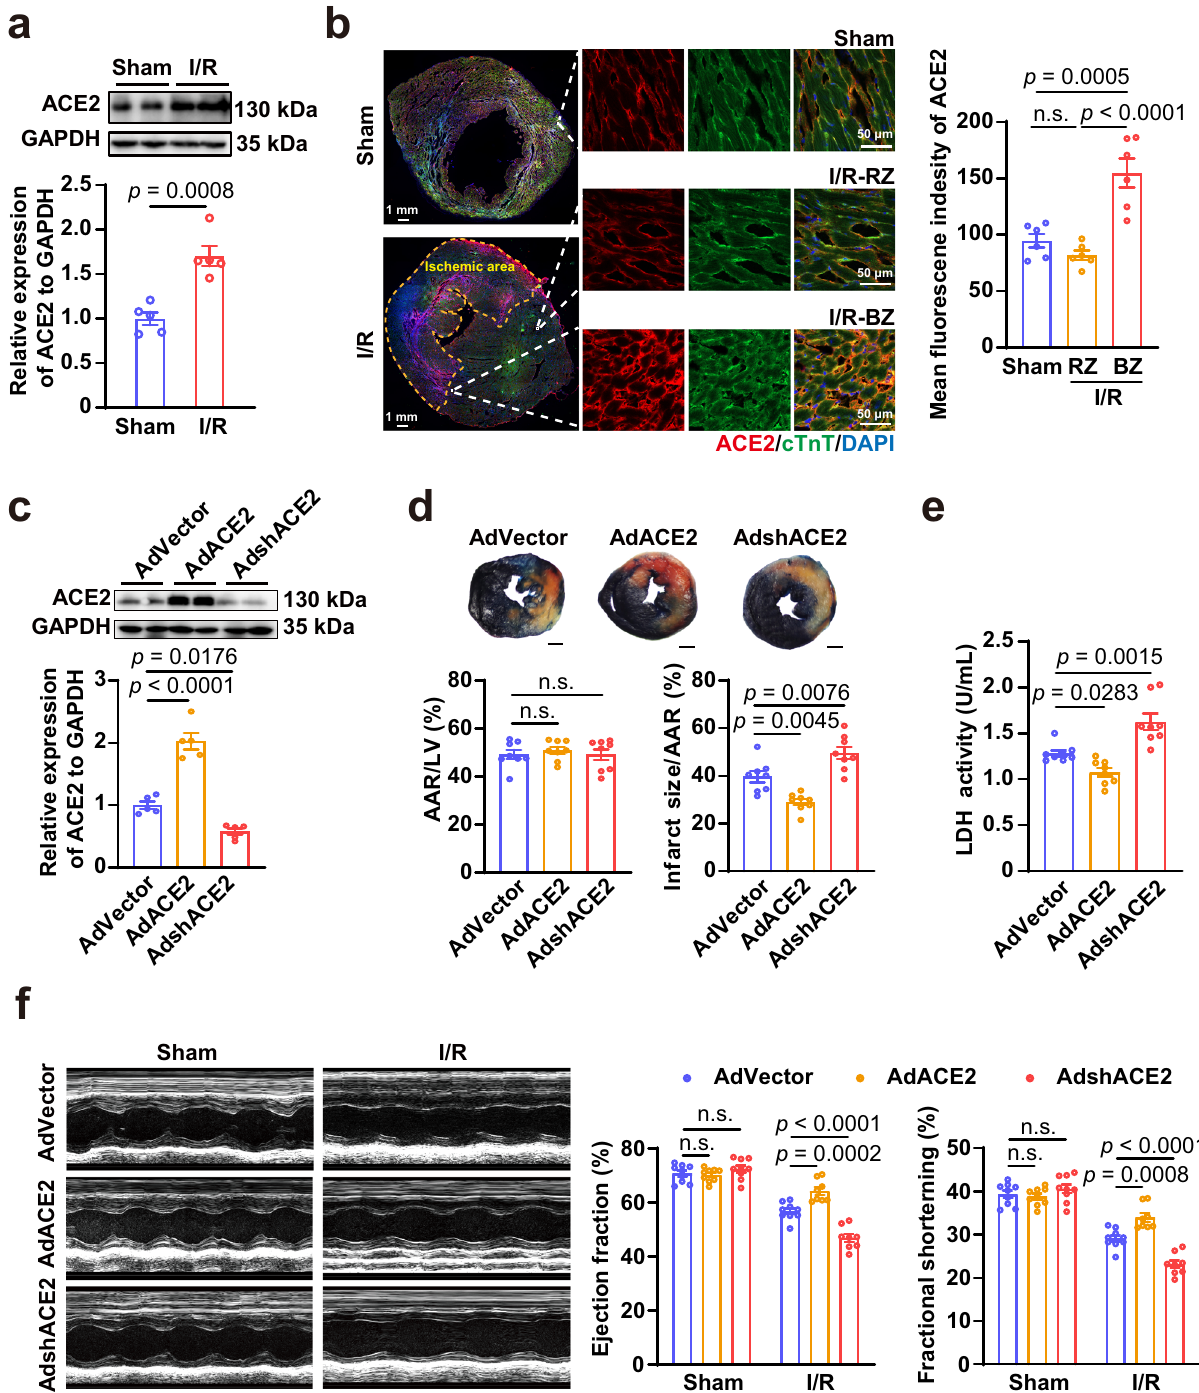
Fig. 1 The protective effect of ACE2 during myocardial I/R injury. a Representative and quantitative immunoblot analysis of ACE2 protein in the hearts after myocardial I/R (45 min/24 h). n = 5 for each group. b Representative immunostaining analysis of ACE2 expression with quanti fi cation of the mean fl uorescence intensity in the hearts after myocardial I/R (45 min/24 h). RZ, remote zone; BZ, border zone. n = 6 for each group. c Representative and quantitative immunoblot analysis of ACE2 protein in the hearts infected with adenovirus-mediated vector control (AdVector), adenovirus-mediated ACE2- overexpression (AdACE2), or adenovirus-mediated ACE2 short hairpin RNA (AdshACE2) for 3 days. n = 5 for each group. d Representative 2, 3, 5-triphenyltetrazolium chloride (TTC)/Evans blue staining (upper) and averaged infarct size (lower) following myocardial I/R (45 min/24 h). AAR, area at risk; LV, left ventricle; n = 8 for each group; Scale bar, 1 mm. e The lactic dehydrogenase (LDH) activity in the serum of mice infected with AdVector, AdACE2, or AdshACE2 following myocardial I/R (45 min/24 h). n = 8 for each group. f Representative M-mode echocardiogram images and statistical analysis of ejection fraction and fractional shortening in the hearts infected with AdVector, AdACE2, or AdshACE2 following myocardial I/R (45 min/24 h). n = 8 – 9 for each group. Statistical signi fi cance was assessed using unpaired, two-tailed Student t test ( a ), one-way ANOVA with Turkey post-test ( b – e ) or 2-way ANOVA with Turkey post-test ( f ). Data are presented as mean ± SEM; n.s., not signi fi cant. COMMUNICATIONS BIOLOGY| (2022) 5:902